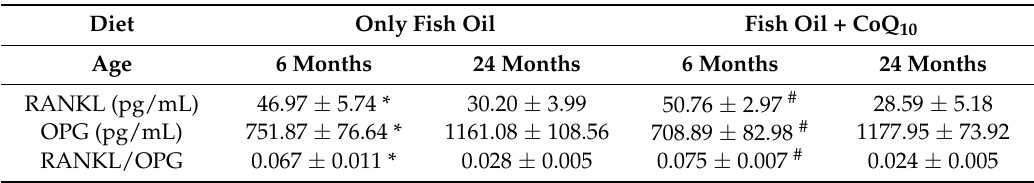
Table 1. Effects of supplementation with coenzyme Q 10 (CoQ 10 ) on serum levels of osteoprotegerin (OPG), receptor activator of the nuclear factor κ B ligand (RANKL), and RANKL/OPG ratio in 6- and 24-month-old (m) rats fed fish oil as dietary fat. Diet Only Fish Oil